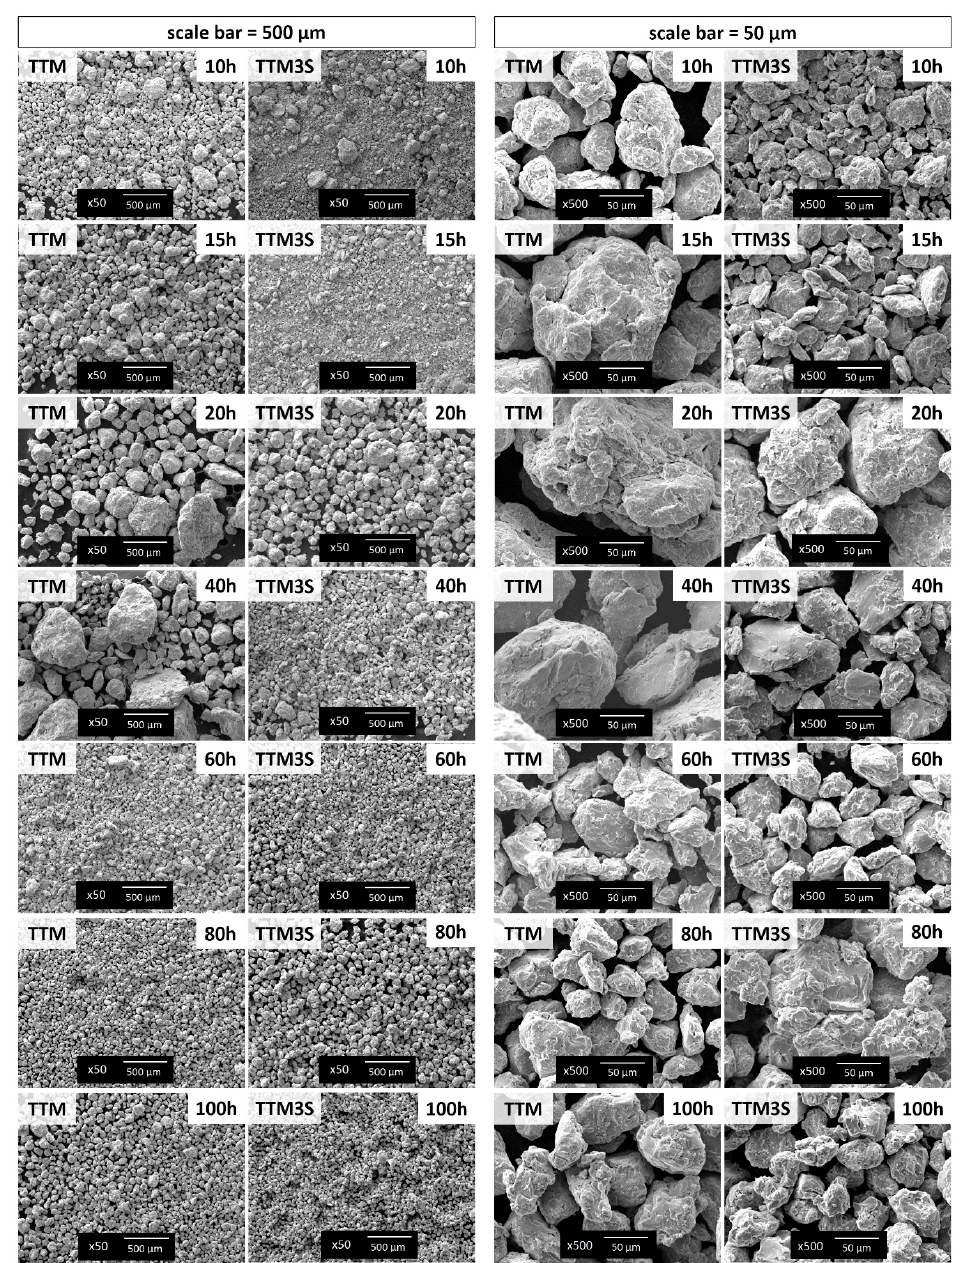
Figure 4. SEM images of TTM and TTM3S powders after 10, 15, 20, 40, 60, 80 and 100 h of milling: left side —scale bar represents 500 μ m; right side —scale bar represents 50 μ m.